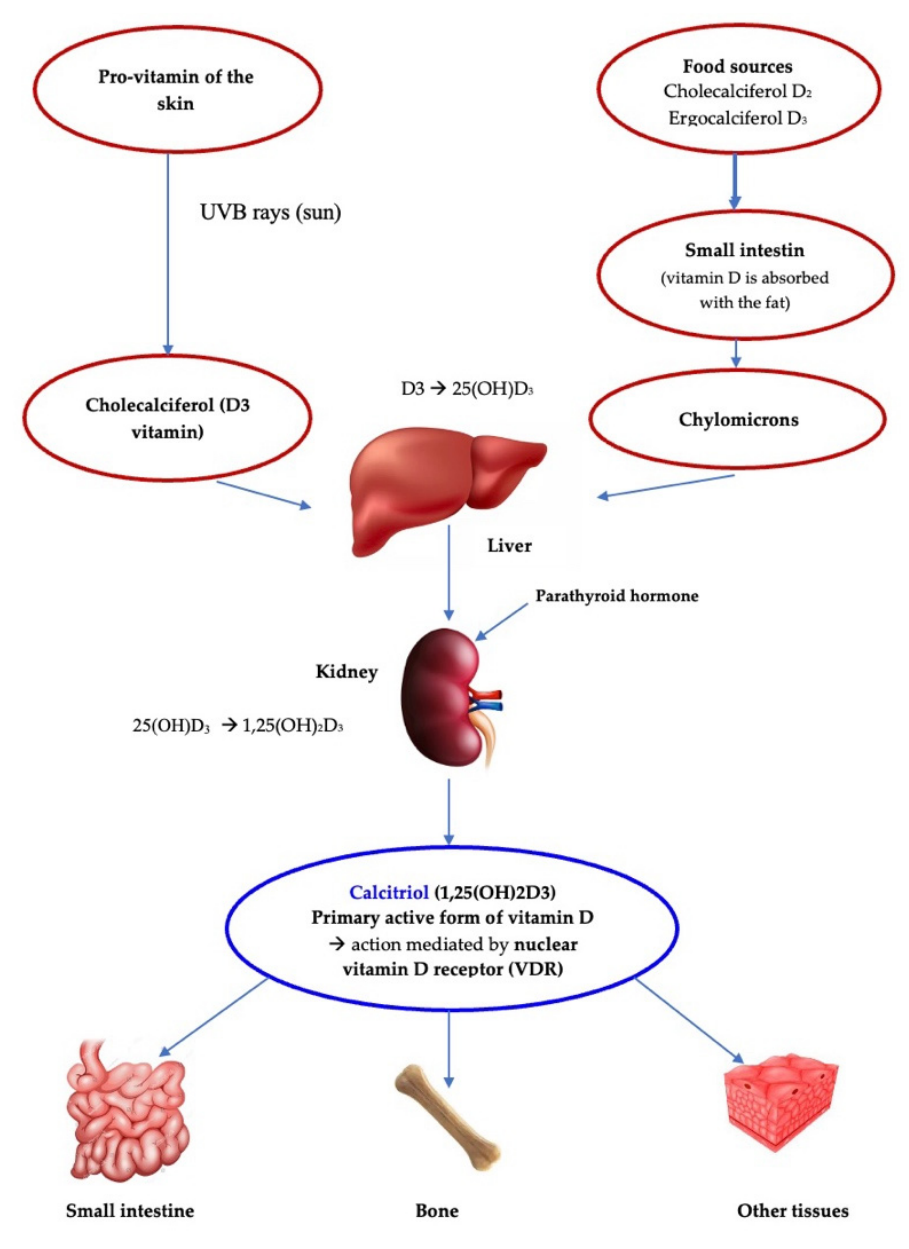
Figure 1. Schematic representation of vitamin D sources and metabolism. indicator for monitoring vitamin D status. In terms of vitamin D status, most